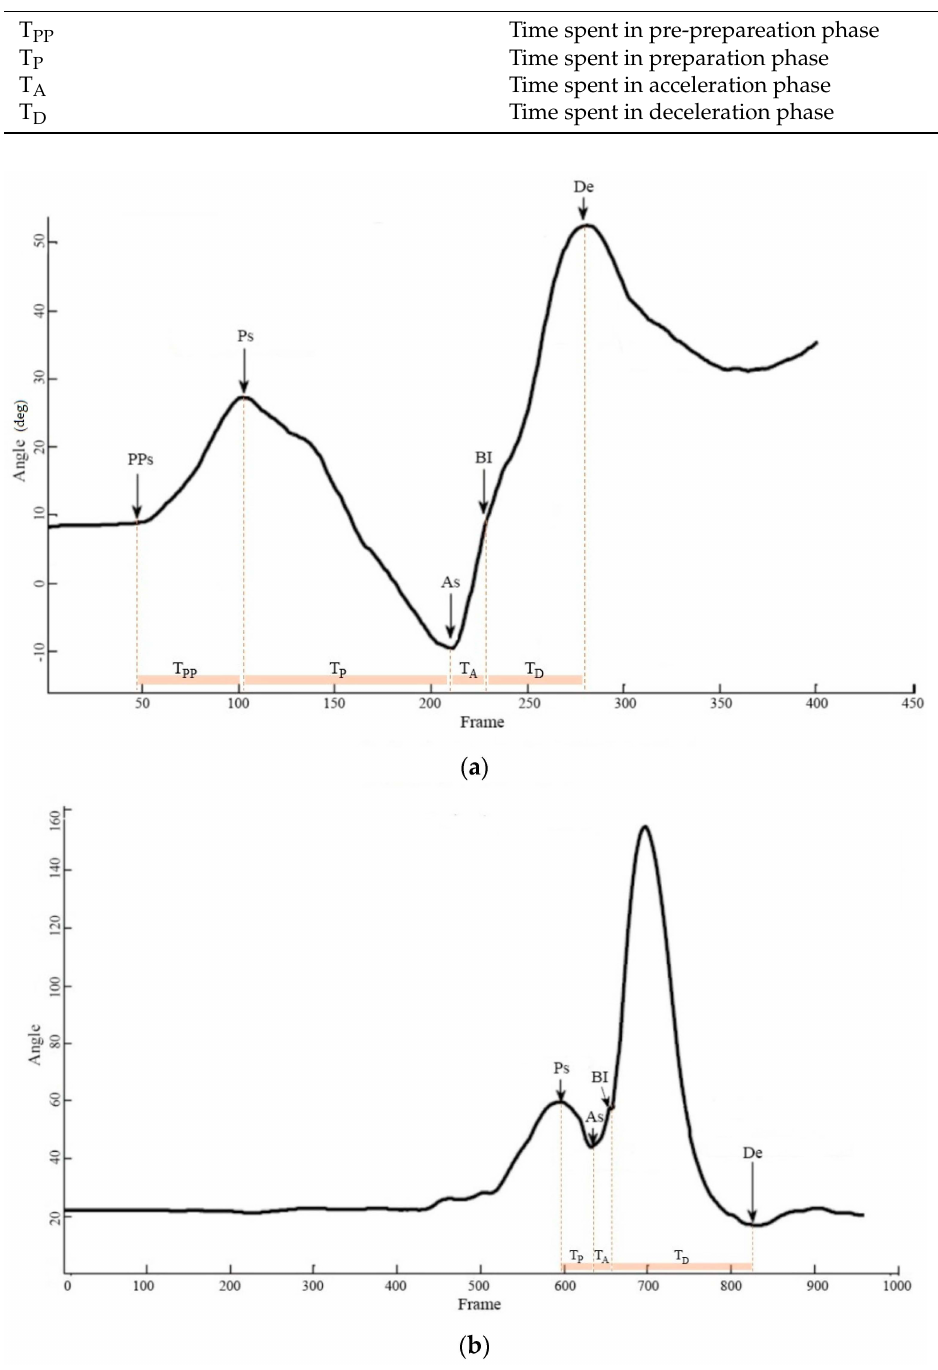
Figure 3. The even and phase on selected signal waveform: ( a ) trunk rotation angle in sitting condition and ( b ) shoulder flexion angle in standing